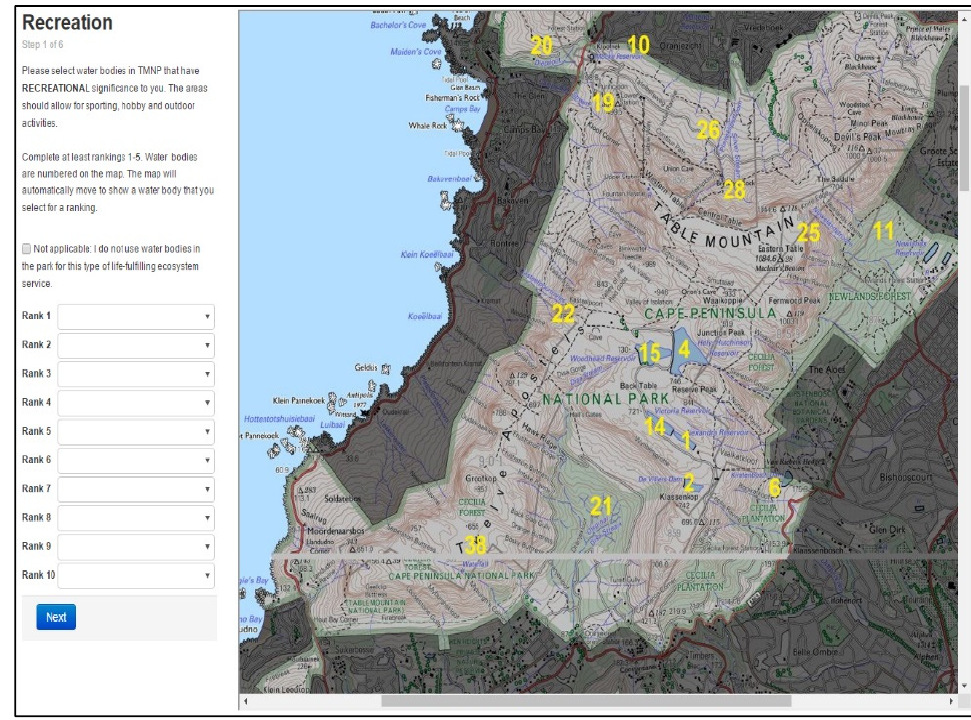
Figure A2. Screenshot of online mapping exercise detailing choice for water bodies in the Table Mountain National Park holding recreational value to survey respondents.